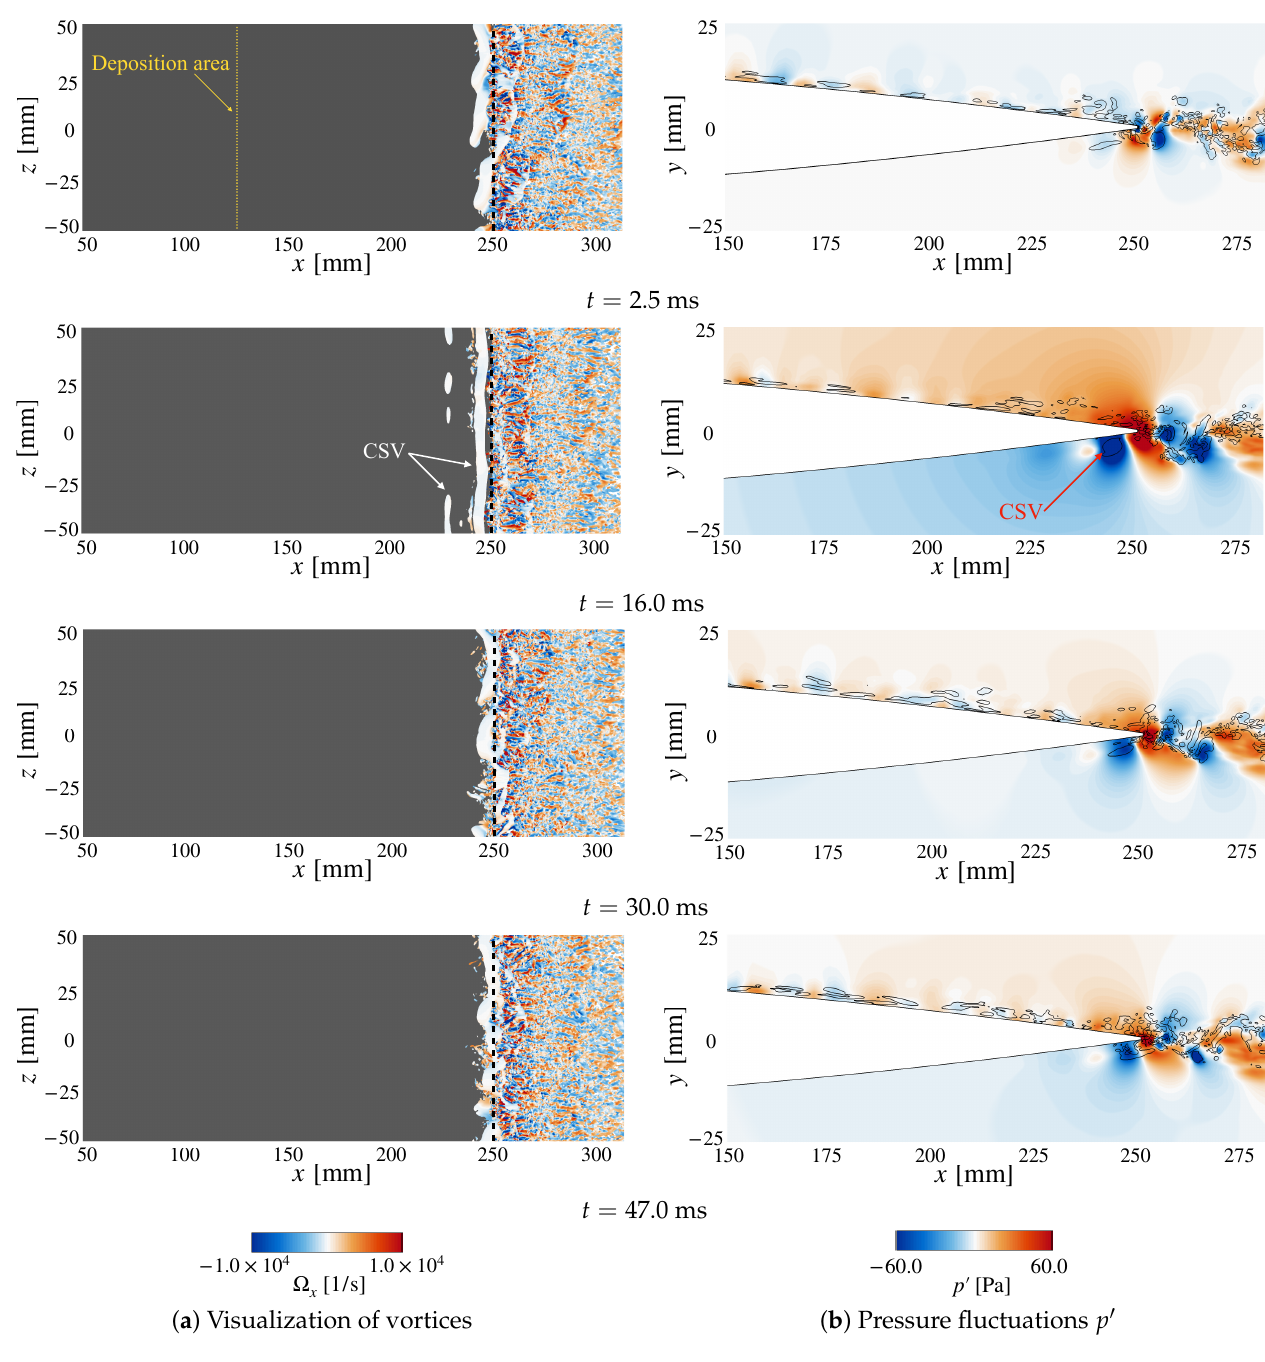
Figure 16. Time series of instantaneous flow field from t = 16.0 ms to 47.0 ms for the Wide case. The definitions of iso-surfaces and contours are the same as in Figure 14. The figure also shows the deposition area with the yellow-dashed